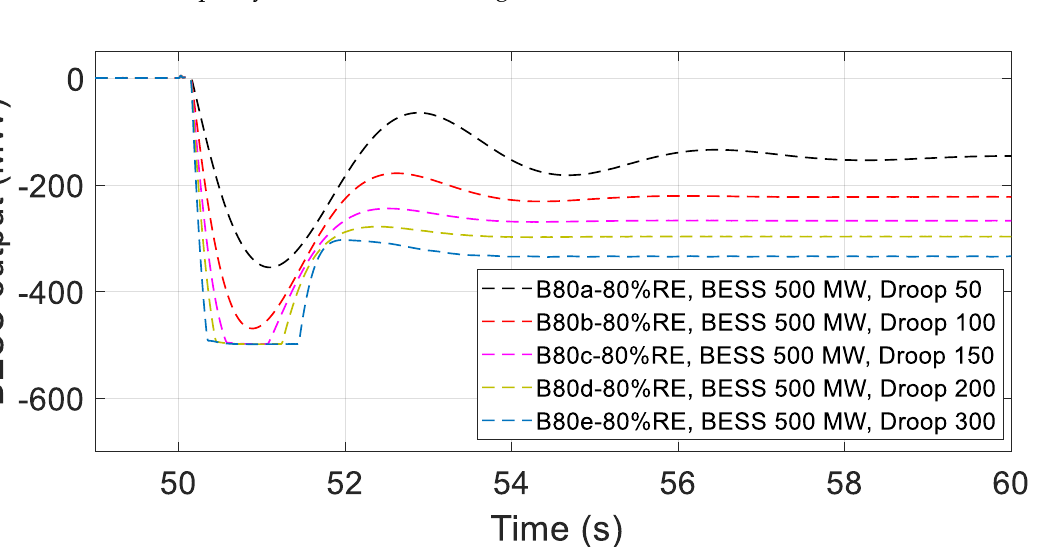
Table 7. Group C, different BESS capacity, fixed droop coefficient, A80—80% RE penetration.